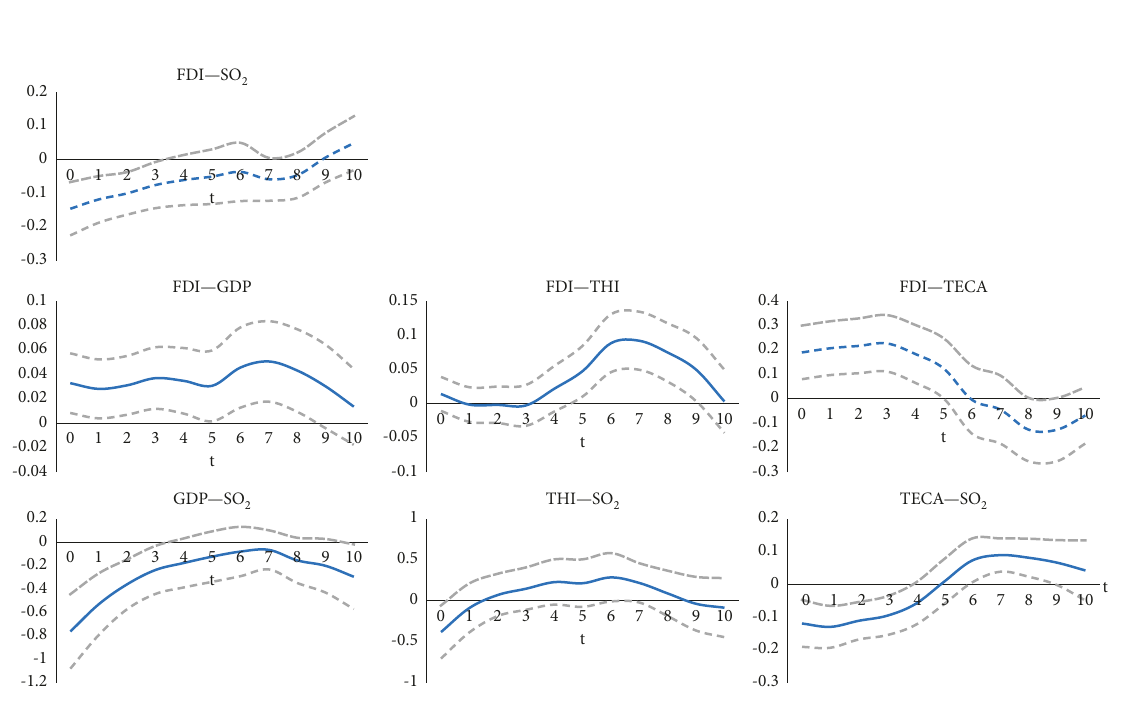
Note. Data in the table are correlation coefficients, and the data in the brackets are p